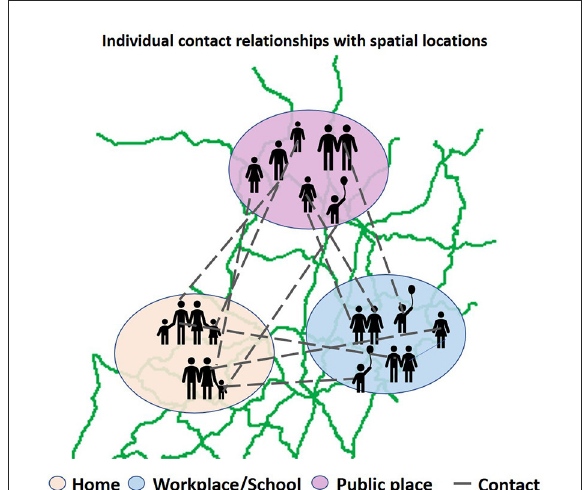
FIGURE5 Agent based model to simulate epidemic transmission in real network. The broken line indicates interactions between agents in various places (home, workplace, school, public